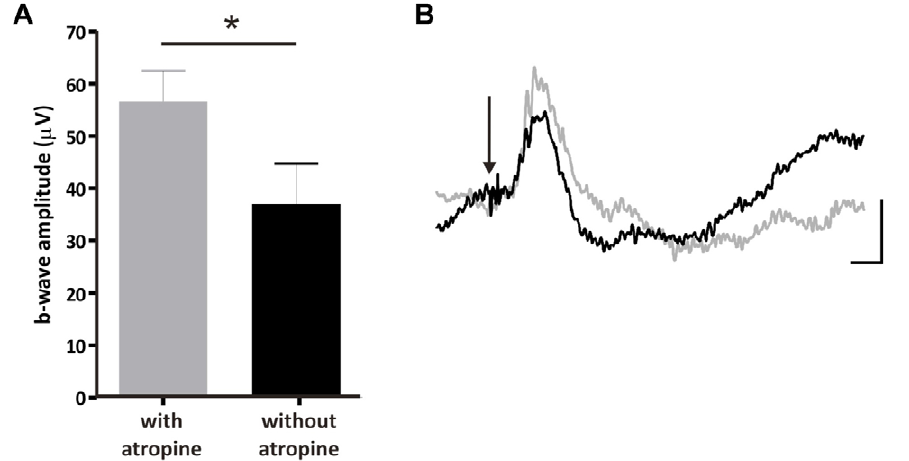
Figure 4. Atropine augments an ERG b-wave preserved in TKO mice. ( A ) b-wave amplitude of flash ERG responses in the presence and absence of atropine drops. A small but significant increase in the ERG b-wave amplitude was apparent following application of atropine drops (data presented as mean 6 SEM; n=5 for each group). This is demonstrated in the average of all ERG responses in each group, shown in ( B ), atropine treated shown in grey, and untreated in black (scale bars: y-axis=25 m V, x-axis=50 ms; n=5 for each group).